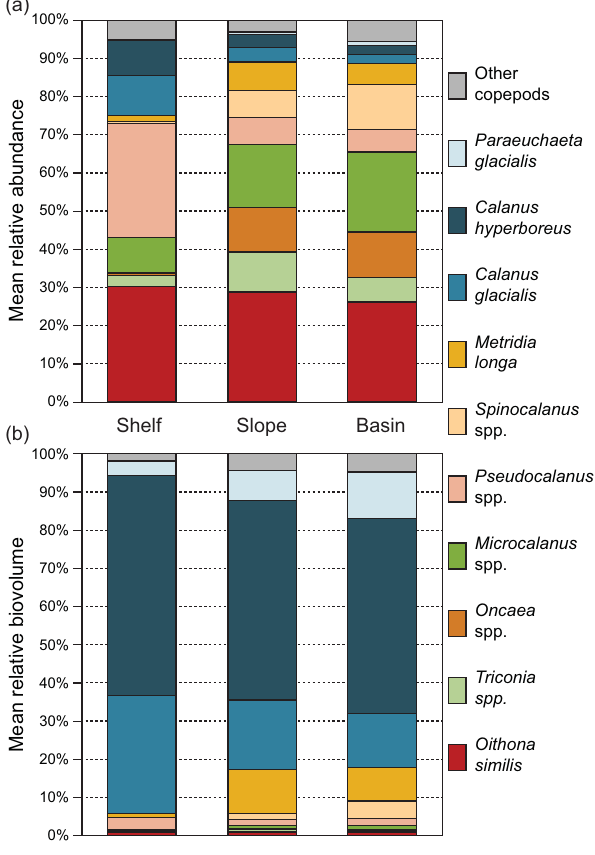
Fig. 7. Relative contribution of dominant copepod species in the to- tal abundance (a) and biovolume (b) of copepod assemblages (cope- podites only) as estimated with bottom-to-surface vertical net tows (200µm mesh size) conducted across the shelf-slope-basin interface in the southeast Beaufort Sea in July–August 2009. The biovolume of each species was estimated using morphometric estimates based on mean prosome and urosome lengths/widths of each copepodite stage (see Sect. 2.3 for details).